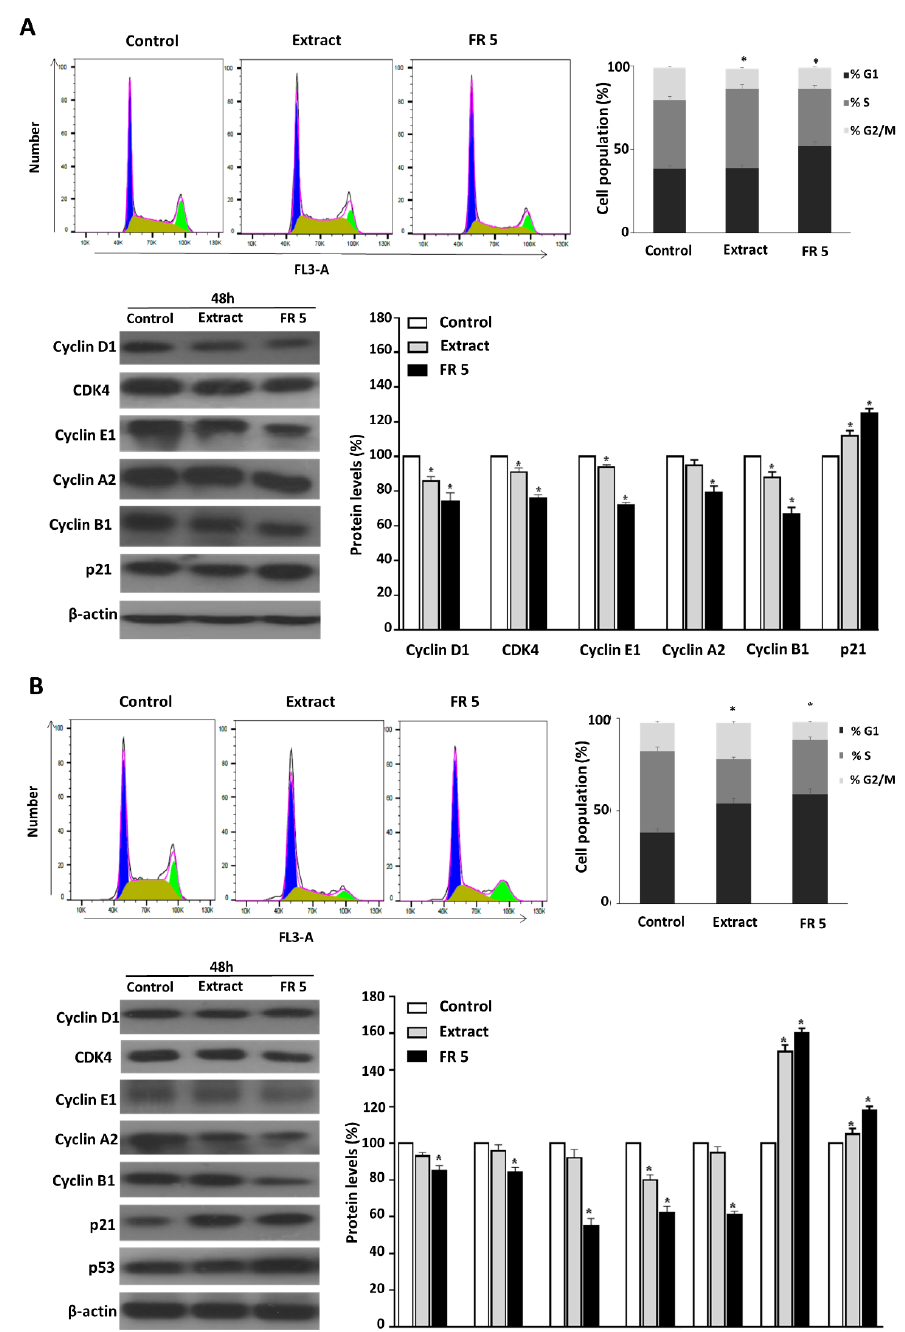
Figure 5. Effect of grape cane extract obtained at pH 7 for 60 min and its polyphenol-rich FR 5 on cell cycle of HNSCC cells. Cal-33 ( A ) and JHU-SCC-011 ( B ) cells were treated for 48 h with 0.25 mg/mL of grape cane extract and 0.10 mg/mL and 0.12 mg/mL of polyphenol-rich FR 5, respectively, then the cell cycle was evaluated by FACS analysis. Bar diagrams show the percentage of cells in each phase of cell cycle. Data represent the average of three independent experiments. The means ± SD are shown. For each sample, at least 2 × 10 4 events were analyzed. * p < 0.05 versus untreated cells. The protein levels of cell cycle regulatory proteins were measured by Western blot and the relative densitometric analyses are reported as percentage of untreated control (100%). The housekeeping protein β -actin was used as a loading control. Error bars represent the standard deviation. * p < 0.05 versus untreated cells. The images are representative of three immunoblotting analyses obtained from three independent experiments. Uncropped images of Western blots are reported in Figure